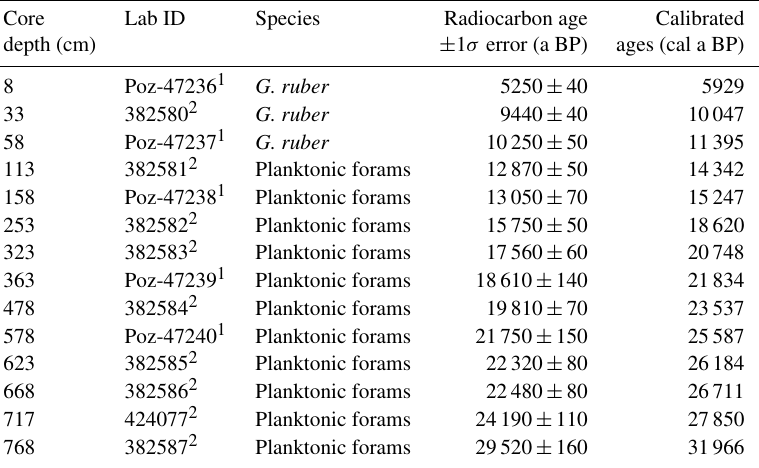
Table 1. Accelerator mass spectrometer radiocarbon dates and calibrated ages used to construct the age model of core GeoB6212-1.